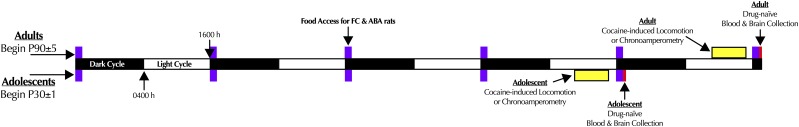
Timeline of experiments. Adult male and female rats were singly housed in cages directly adjoining running wheels at postnatal day 90 (P90, ±5 days), whereas adolescent male and female rats were housed in the same setup at P30 (±1 day). Cage control (CC) and exercise control (EC) animals had 24-hour access to food, whereas food restricted control (FC) and activity-based anorexia (ABA) animals were given access to food for 1 hour per day (purple blocks) at the onset of the dark cycle (1600 hours, 12:12 dark/light cycle, lights on at 0400 hours). Adolescents went through the paradigm for 4 days, adults for 5 days. At the end of the paradigm, animals underwent one of three endpoints: chronoamperometry (between 0900 and 1500 hours; yellow block), cocaine-induced locomotion (between 1000 and 1500 hours; yellow block), or postprandial drug-naive blood and brain collection (1700 hours, red block).